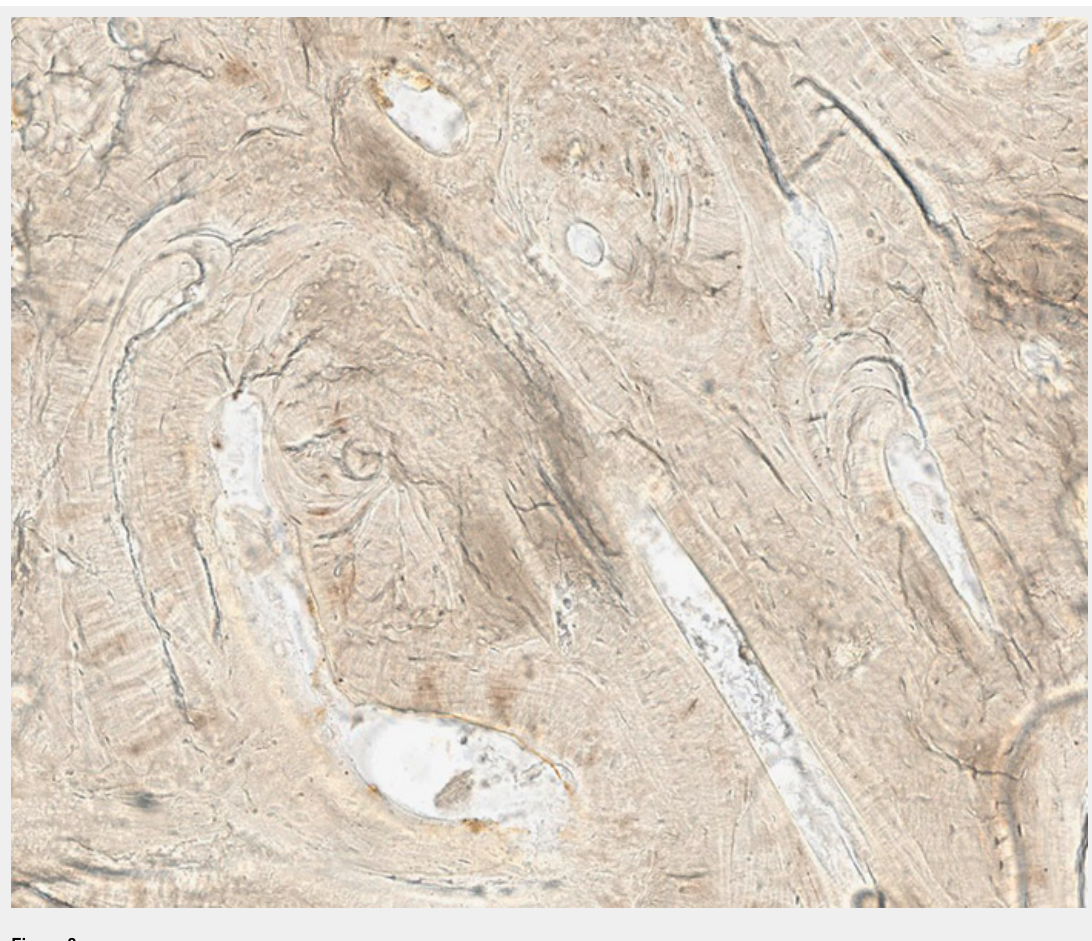
Figure 8 Hard-cut section 40x. Sample taken out of the